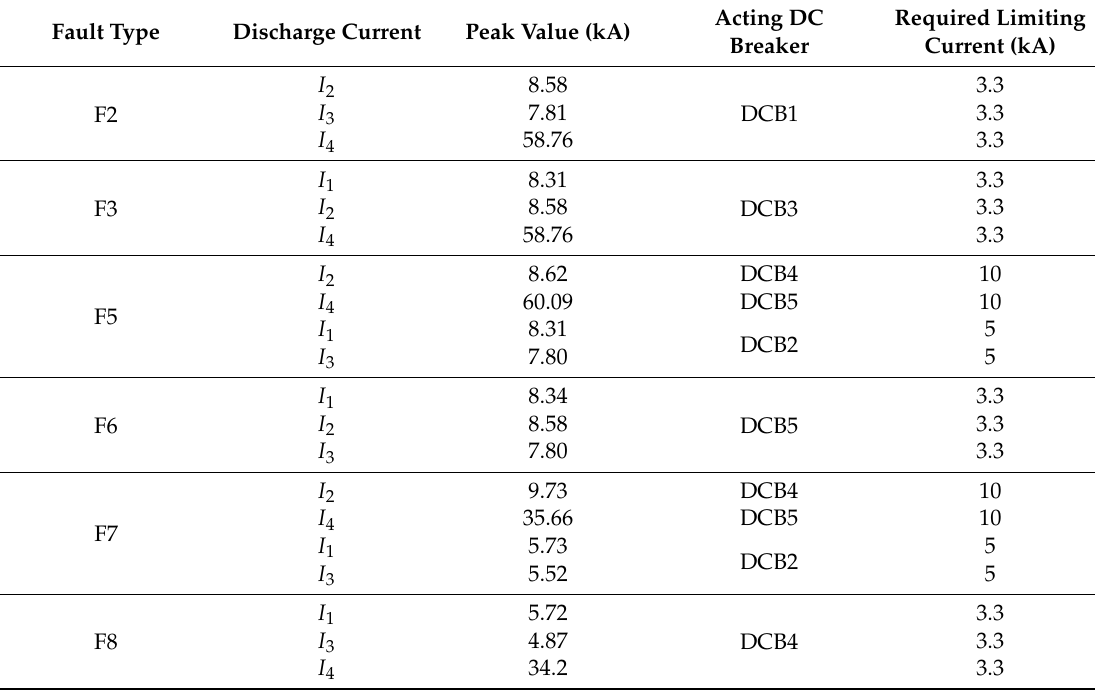
Table 5. Comparison of fault current and required limiting current of each